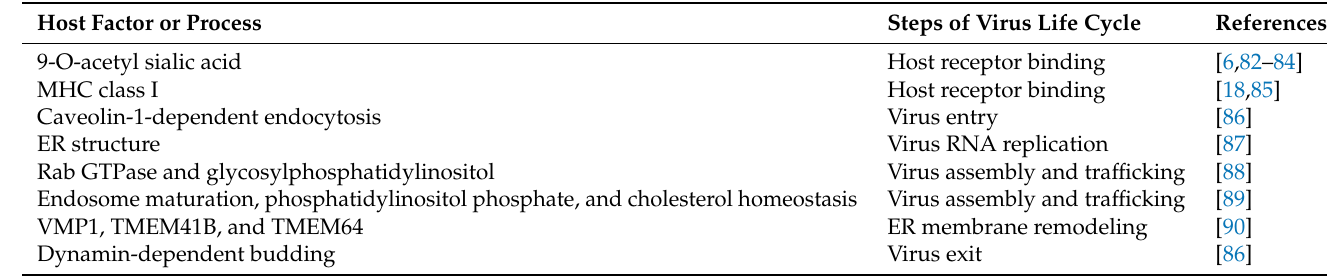
Table 2. Host factors or processes identified necessary for the HCoV-OC43 life